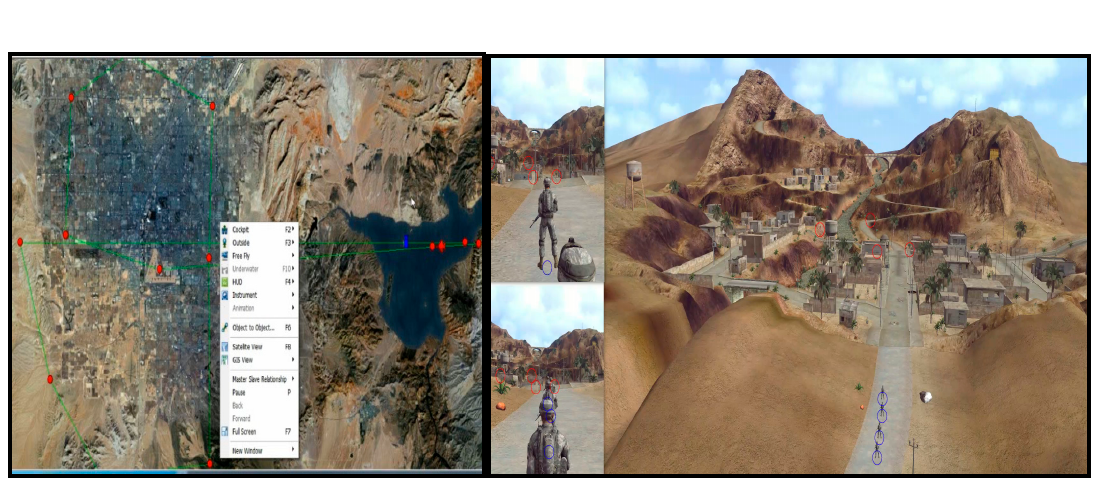
Figure 1. Different types of simulation models in the military. Figure 1. Di ff erent types of simulation models in the